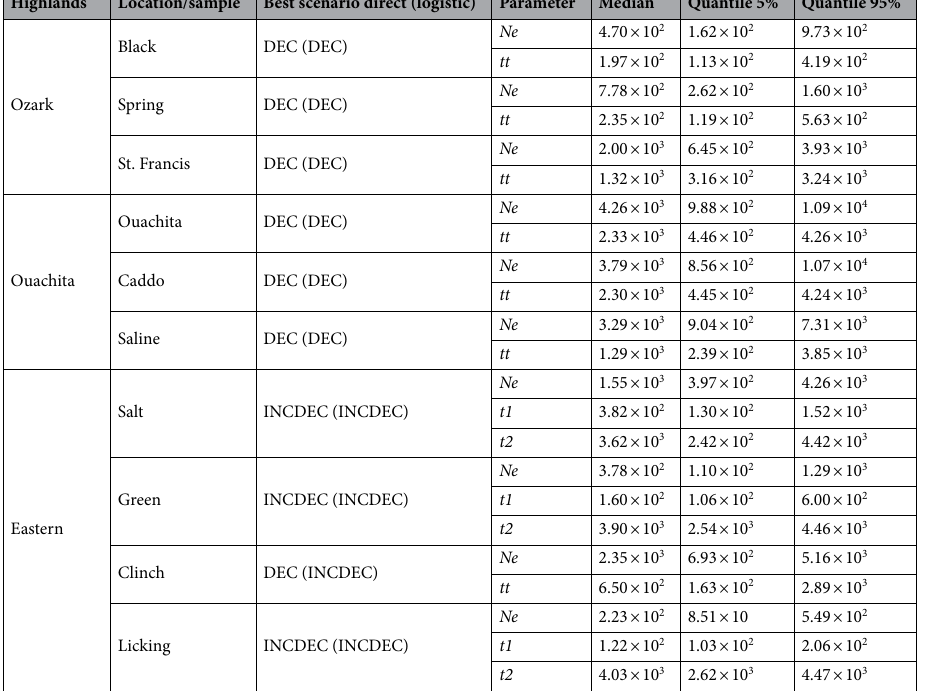
Table 5. Best fit demographic model and posterior distribution of the current effective population sizes ( Ne ) e and generation time ( T ) (Median and 95% credible interval) for each Cyprogenia sample site using ABC simulation implemented in DIYABC. Five demographic models proposed by by Cabrera and Palsbøll 81 are evaluated. Model 1: CON (constant population size), Model 2: DEC (a single instantaneous decrease in population size), Model 3: INC (a single instantaneous increase in population size), Model 4: INCDEC (a single instantaneous increase followed by a single instantaneous decrease in population size), Model 5: DECINC (a single instantaneous decrease followed by a single instantaneous increase in population size). Time is in number of generations assuming a generation time of 5 years for Cyprogenia ; tt denotes a unique event after the LGM, t1 and t2 denote an event after and before the LGM. Detailed prior model parameterization for five demographic models was provided in “Supplementary Information”. No mutation model parameterization was required for SNPs.